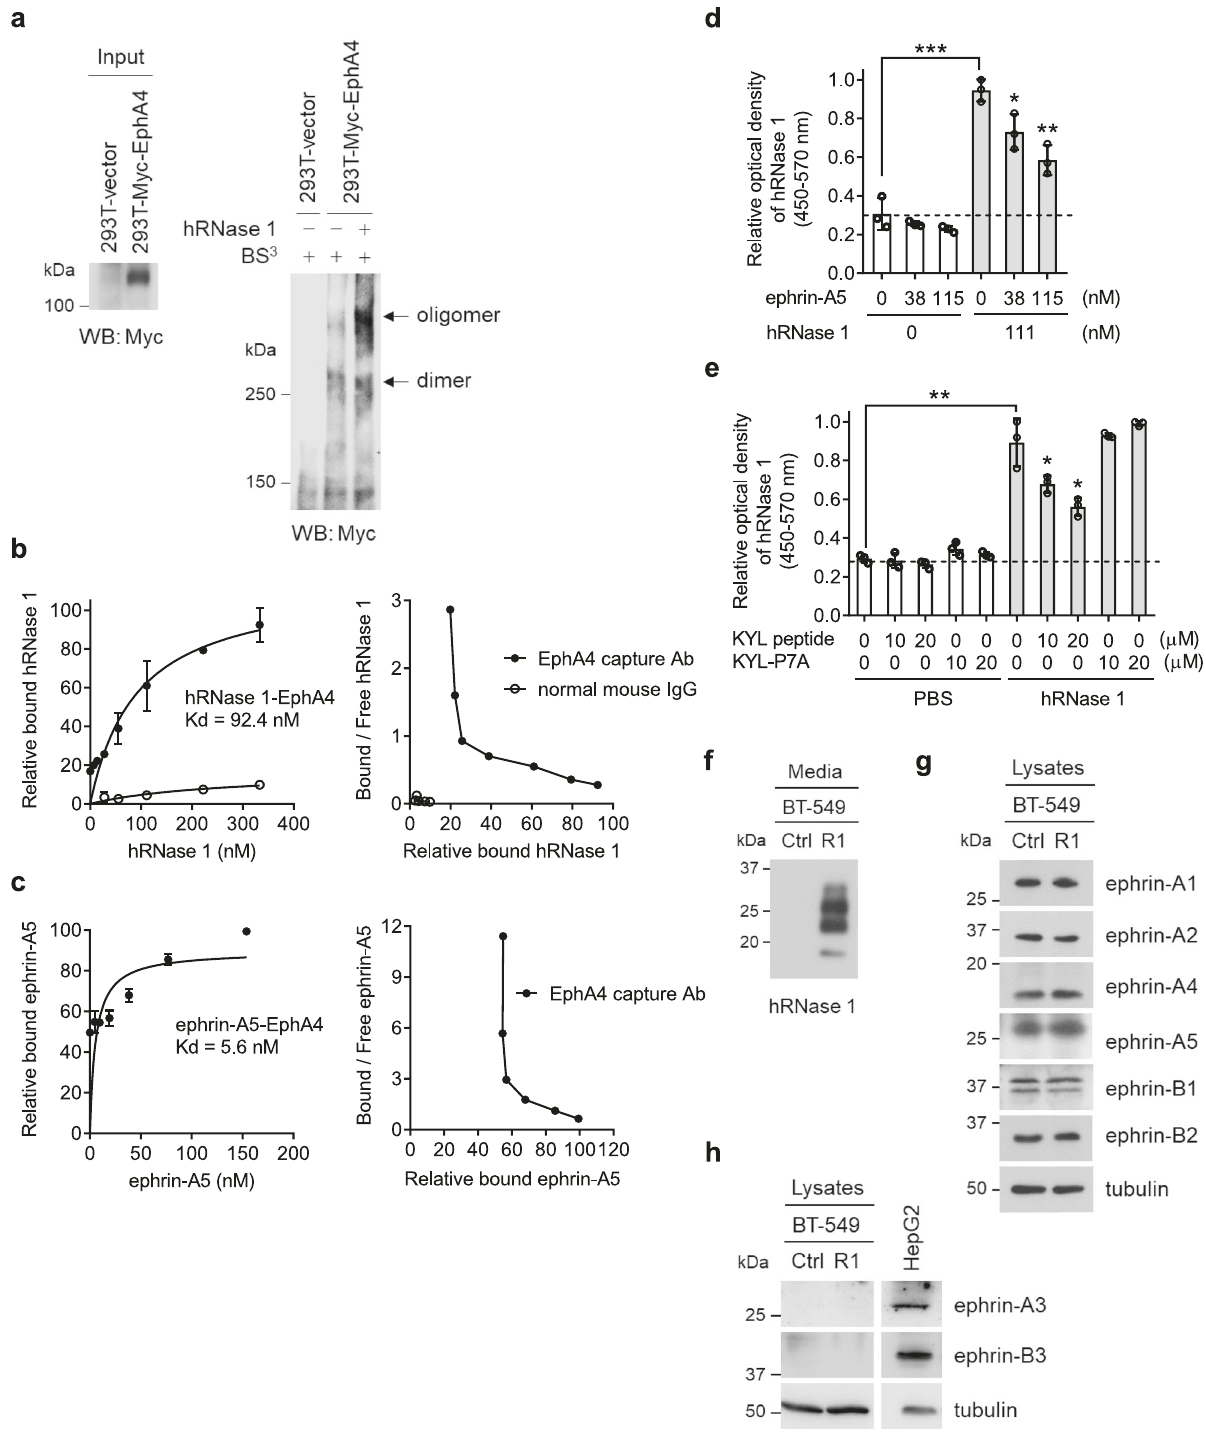
Fig. 5 hRNase 1 induces EphA4 dimerization/oligomerization and its binding to EphA4 partially overlaps with that of ephrin A5. a Dimerization assay of 293T cells ectopically expressing Myc-tagged EphA4 or vector control, cross-linked with bis(sulfosuccinimidyl)suberate (BS 3 ) followed by WB under a non-reducing and non-denaturing condition. Left, input lysates. b , c Left, saturation binding assay of the Kd values determination for hRNase 1 ( b ) or ephrin- A5 ( c ) binding toward EphA4 in BT-549 cell lysates. Right, scatchard plot. Negative control, normal mouse IgG. Each experiment was performed twice in triplicate. d , e Binding assay measuring hRNase 1 binding af fi nity toward EphA4 in BT-549 cells with increasing concentrations of ephrin-A5 ( d ) and KYL or KYL-P7A peptide ( e ) as indicated. The optical density was determined at 450 nm, corrected by subtraction of reading at 570 nm. * p < 0.05, ** p < 0.01, *** p < 0.001, two-tailed unpaired t test. f – h WB of secreted proteins from CM ( f ) and lysates ( g , h ) in BT-549-Ctrl and BT-549-R1 stable clones. Positive control, HepG2 cell lysates. Data are representative of two ( a ) or three ( f – h ) independent experiments with similar results. Error bars represent mean ± SD, n = 3 independent experiments ( b – e ). Source data are provided as a Source Data fi